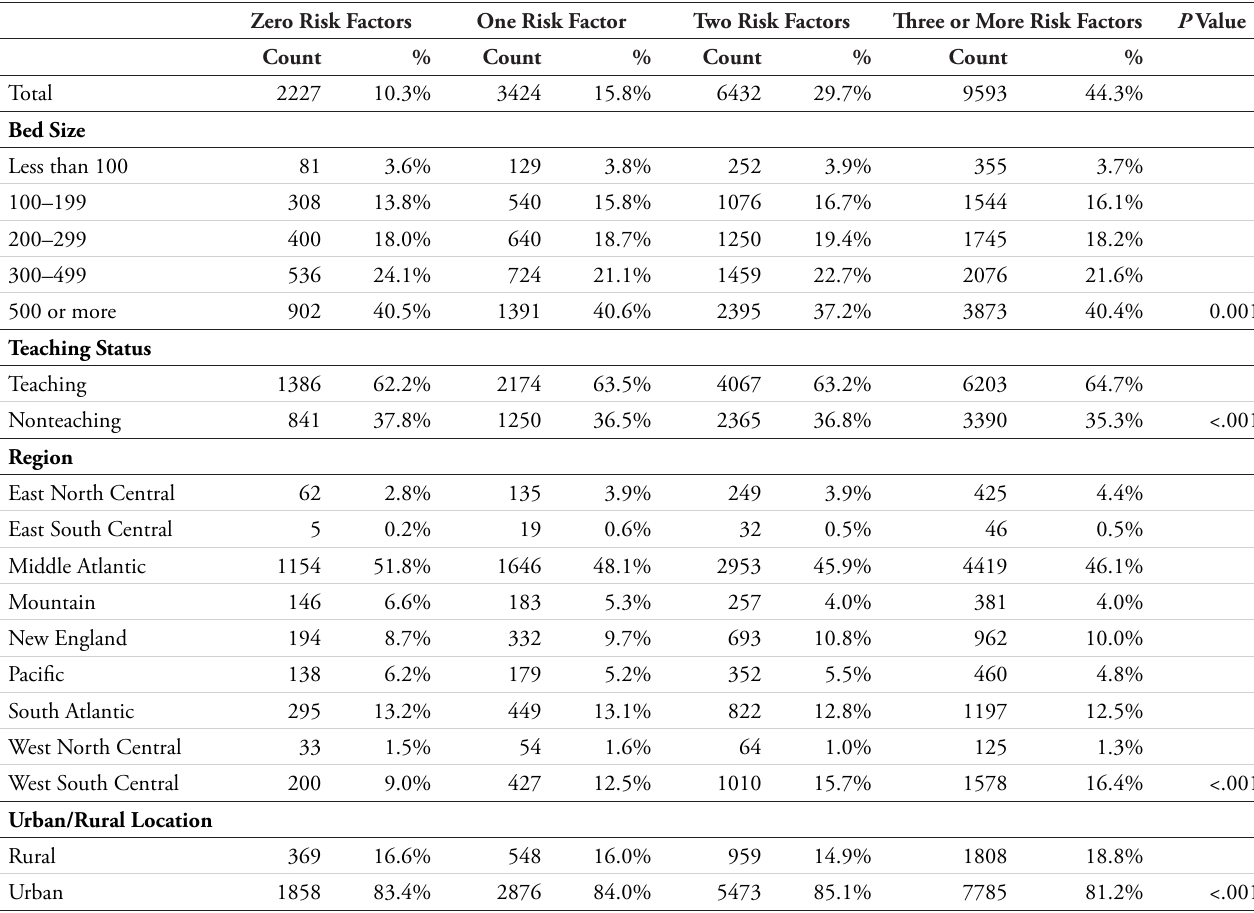
Table 2. Hospital Characteristics of COVID-19 Patient